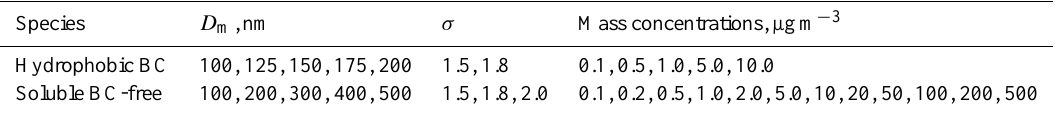
Table A1. Summary of parameters used in the estimation of coagulation effects. ∗ Species D m ,nm σ Mass concentrations, µgm − 3 Hydrophobic